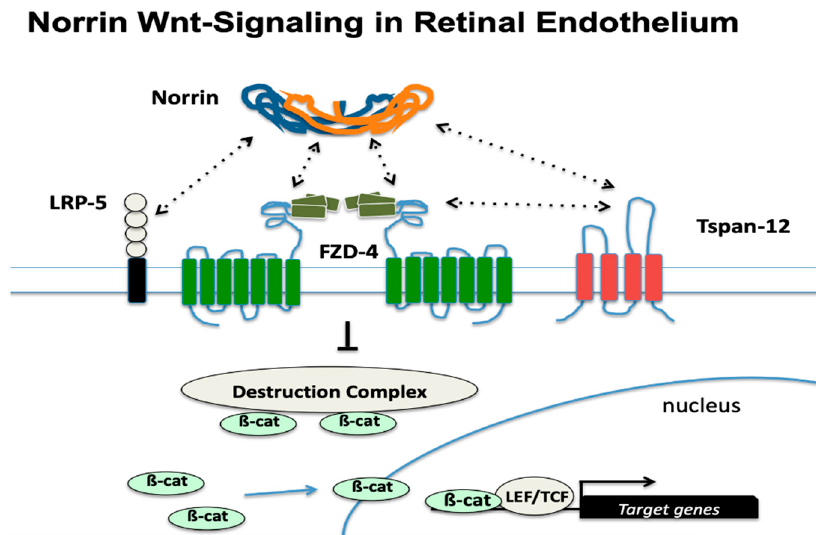
Figure 1. Norrin-based Wnt-signaling in retinal endothelial cells. Lack of Norrin-based Wnt-signaling results in underdevelopment of the microvascular beds and failure to develop a patent high-barrier vascular endothelium in the neural retina and in the cochlea. A Norrin dimer can bind to its central cognate receptor Frizzled-4 (FZD-4) as well as the co-receptors LRP-5 and TSPAN-12. Activation of the receptor complex is increased by the synergy of multiple protein–protein interactions (dashed arrows), inhibiting the ubiquitination of phosphorylated β -Catenin, which then accumulates on the destruction complex [11]. When Norrin is available, this effect causes an increase in cytoplasmic β -Catenin concentration, which enters the nucleus to modulate target gene expression through interactions with the TCF/LEF family of transcription factors as well as other transcription factors that remain unknown.